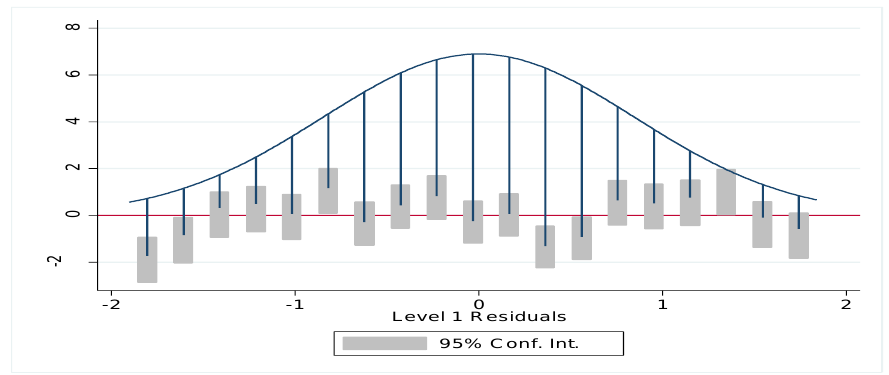
Figure 3: Rootograms for level-1 residuals; Assurance Customer satisfaction model To further explore the nature of the distribution of level one residuals within each insurance company, q-q plots were fitted for each group (insurer) and presented as a line-up of q-q plots (Figure 4). Compared to the q-q plot of all the cases, the test by group showed no notable deviations from the theoretical normal distribution in any of the q-q plots. The plots were well aligned along the theoretical distribution line in each graph. this model, only the level-1 residuals within insurers 10, 12, 13, 15 and 17 showed deviation from